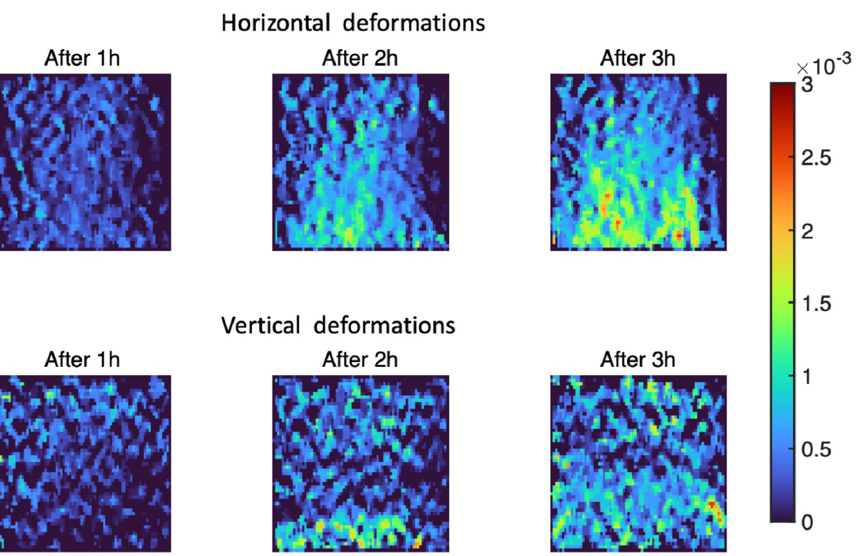
Figure 13. Deformation maps obtained for sample 1 in horizontal and vertical directions at different moments after the rock immersion.